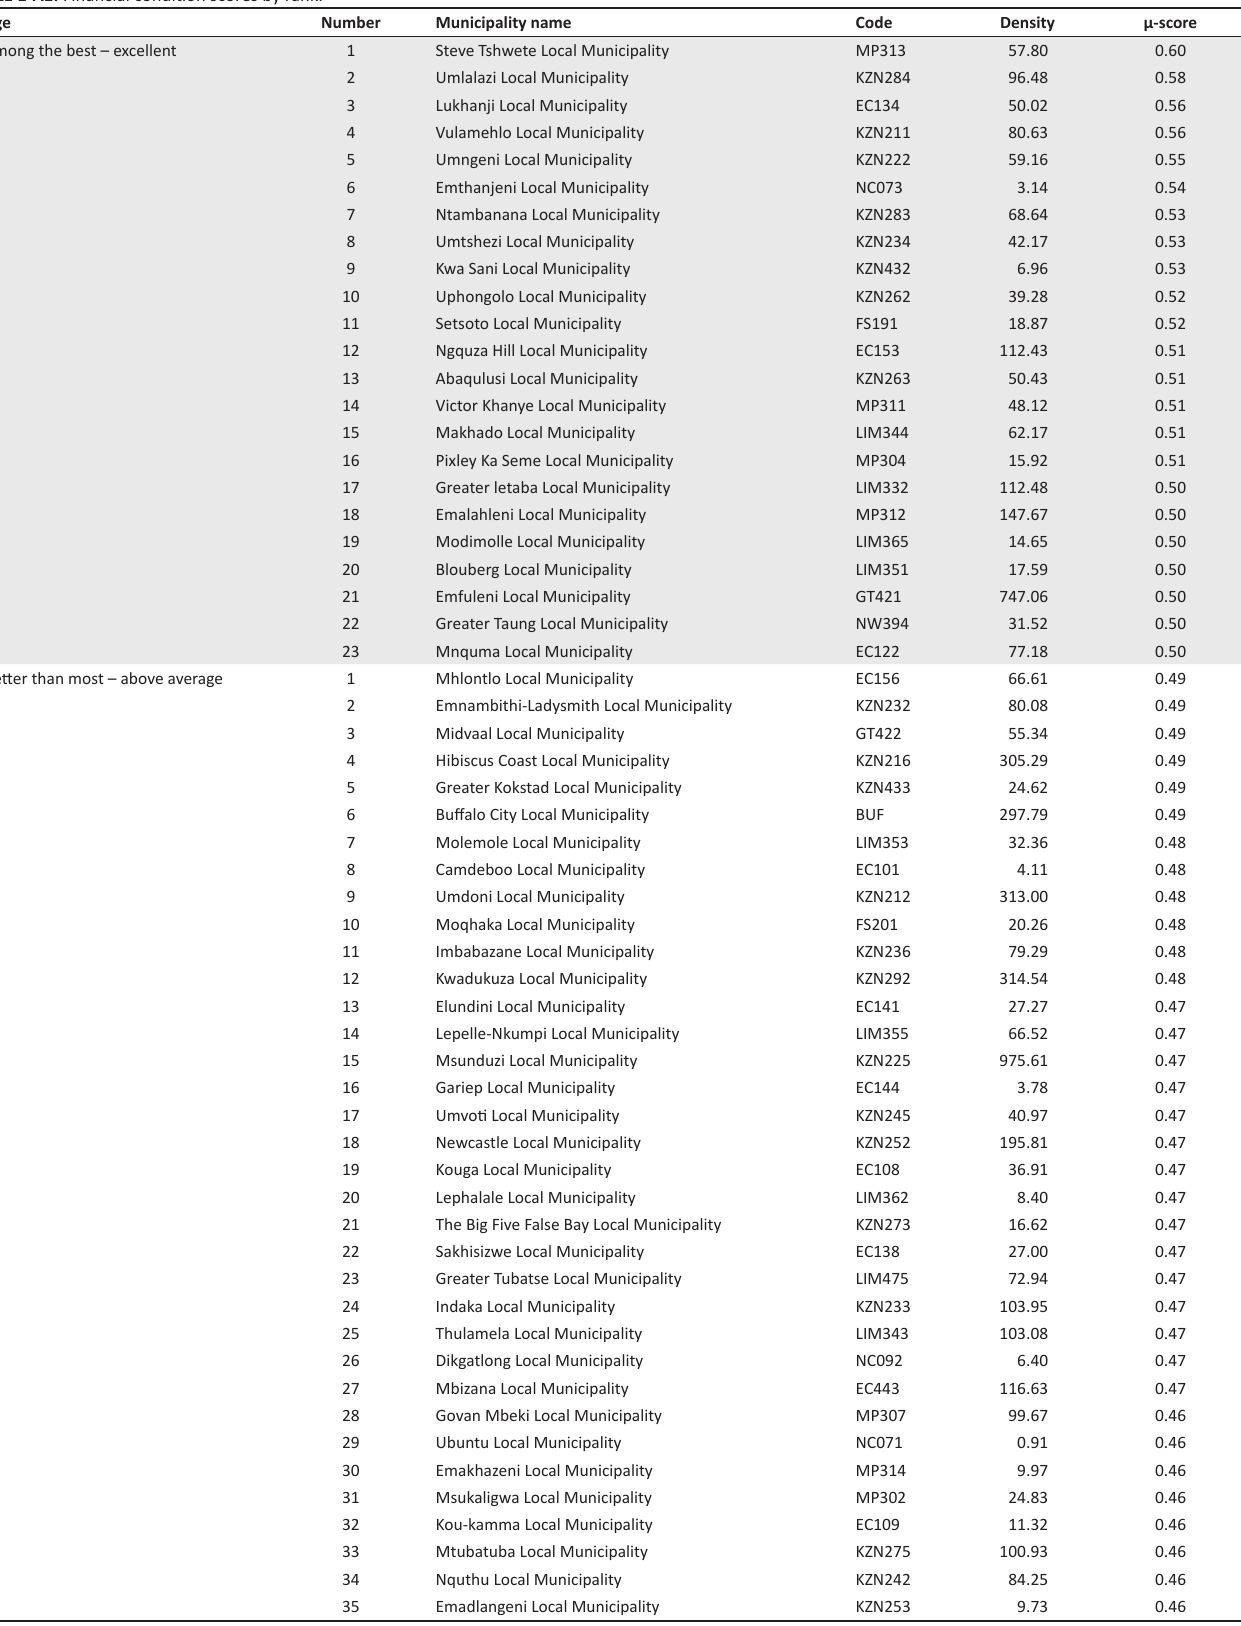
TABLE 1-A1: Financial condition scores by rank.